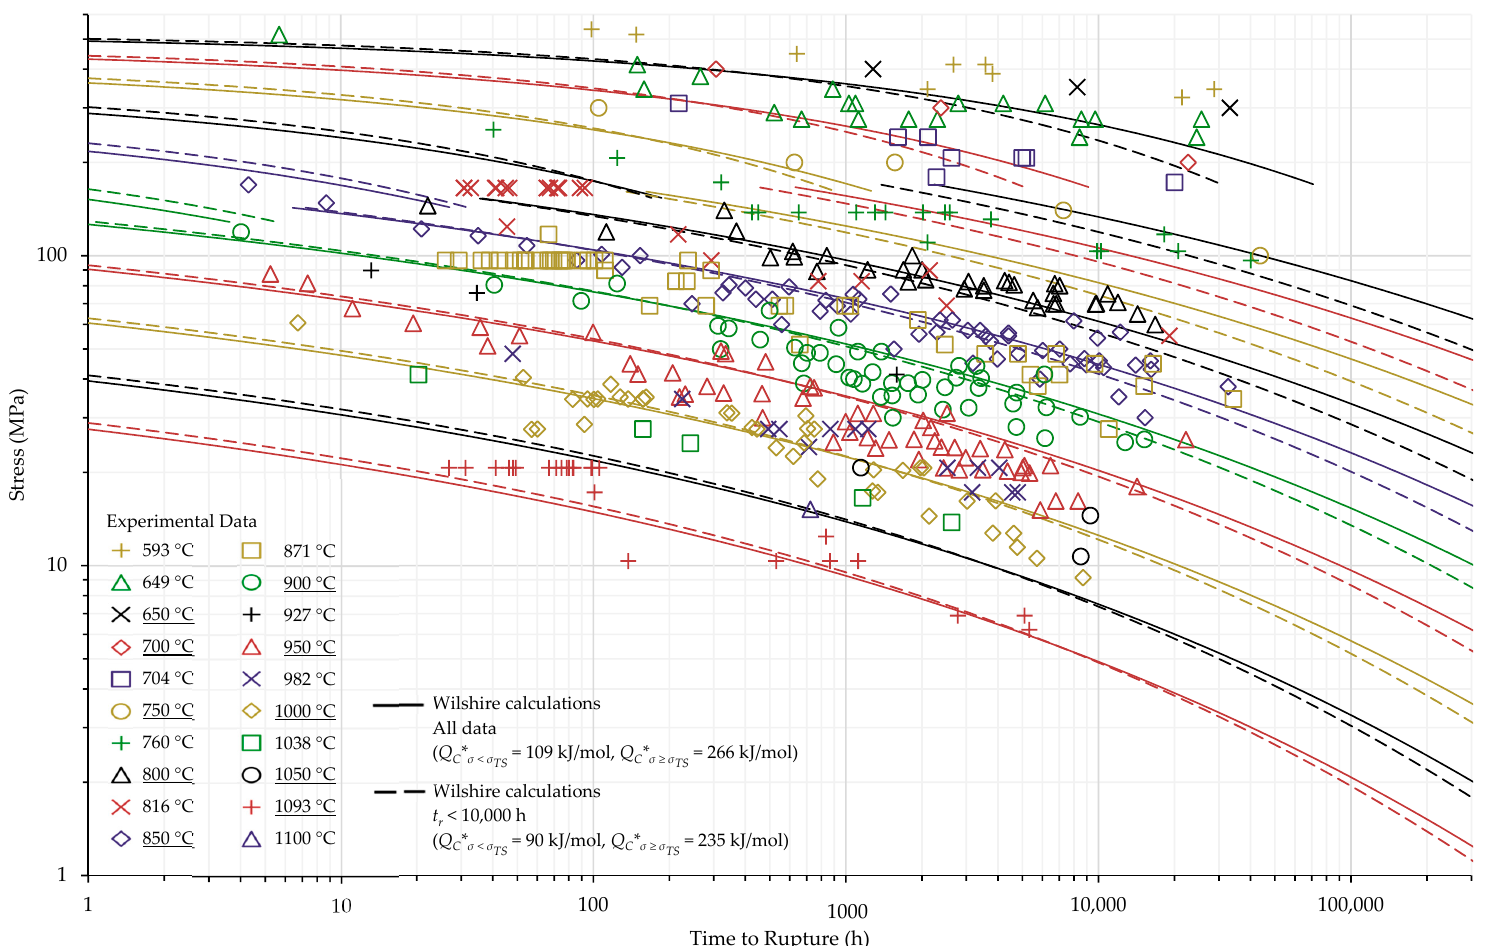
Figure 4. Split region calculations of the Wilshire equation with the lowest error for Inconel 617 shown at underlined temperatures.